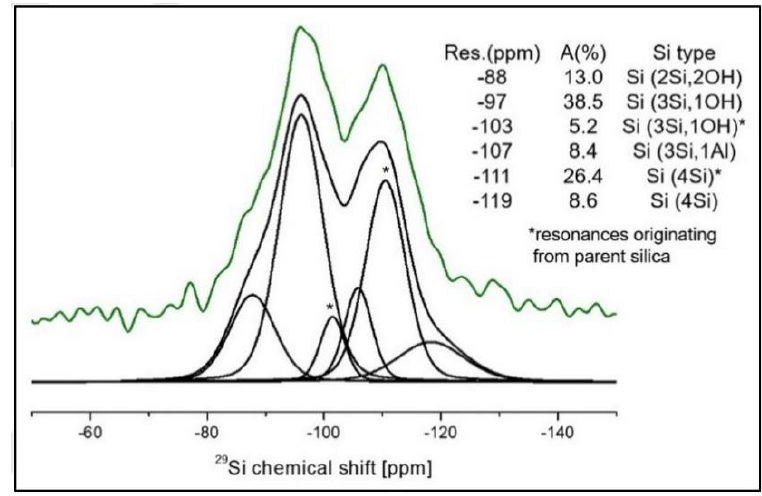
Figure 8. Deconvolution of the 29 Si MAS NMR spectra of the mixture after milling pretreatment (Reprinted with permission from [43]. Copyright: 2020, John Wiley and sons.).